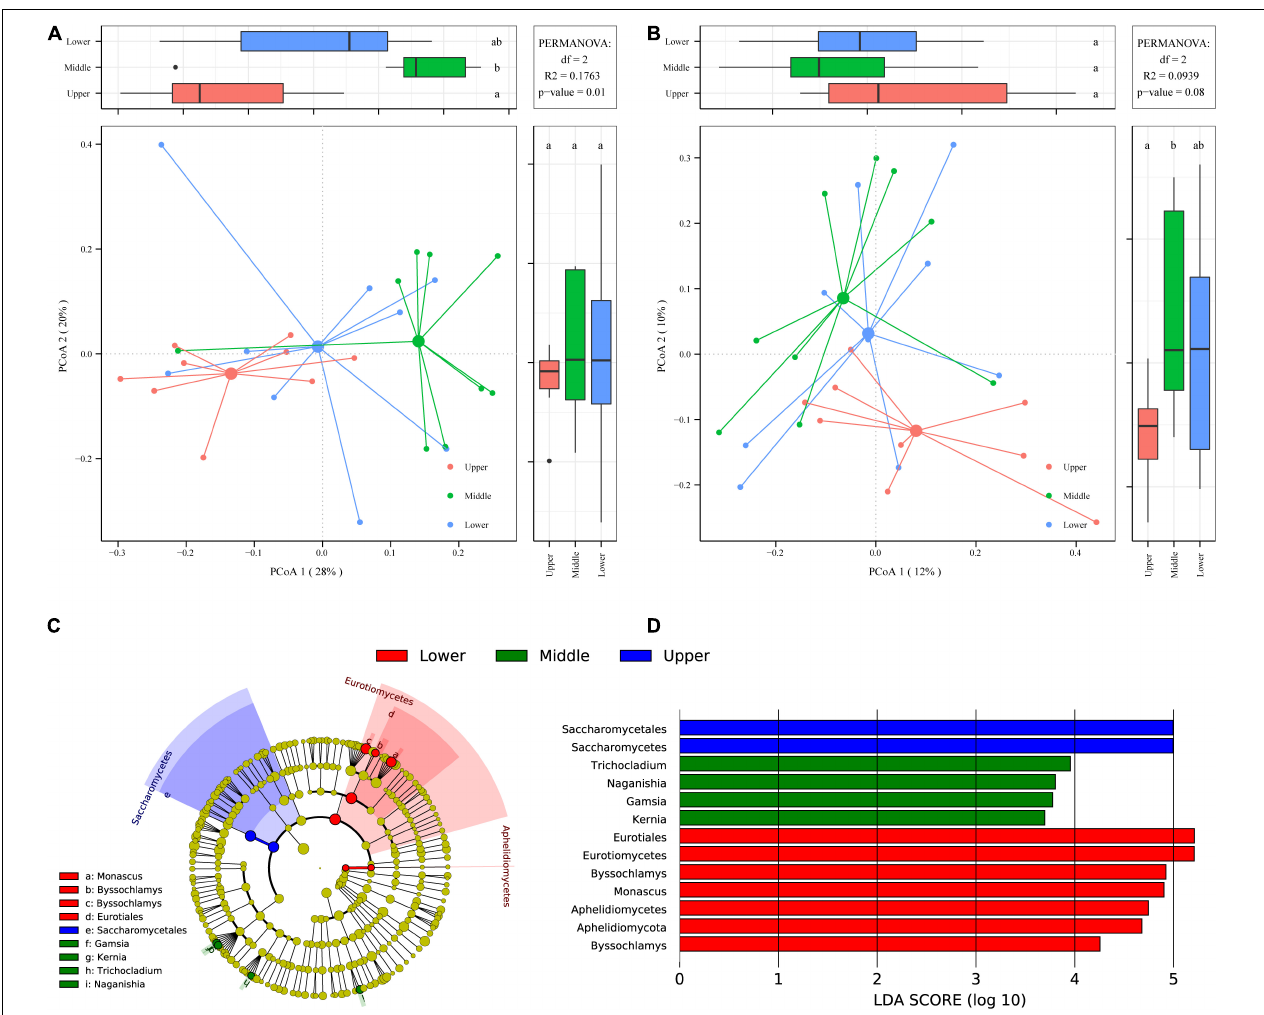
FIGURE 5 | PCoA score plots based on weighted (A) and unweighted (B) UniFrac distances. Identification of discriminant taxa among PM samples at different depths by LEfSe: Cladogram of the fungal communities (C). Horizontal bar chart showing discriminant taxa (D)